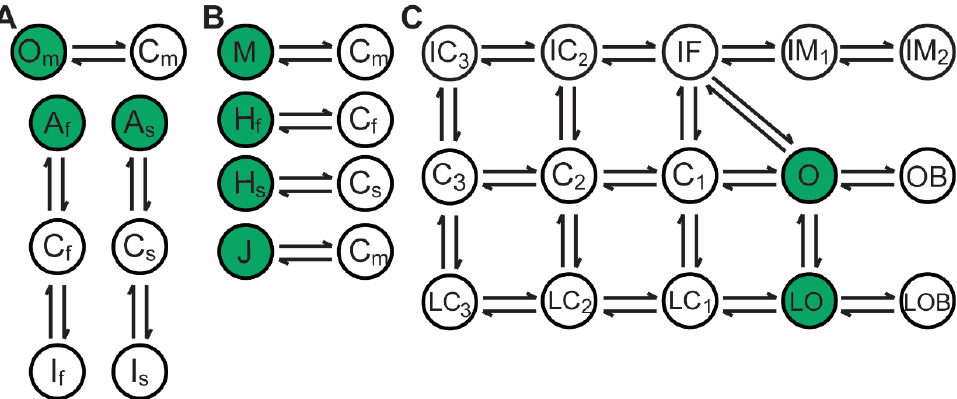
Figure 1. Examples of three different biophysical models of the volgate-gated Na + (Na v ) channel. Open/Active states are indicated in green, while closed/inactive states are white. ( A ) Our novel hybrid Na v model with 3 independent components, an activation component (subscript m ), and two inactivation components for fast and slow inactivation (subscripts f and s , respectively). The activation component consists of an open ( O m ) and closed ( C m ) state, while the inactivation components each consist of an active state ( A ), a closed state ( C ) and an inactivated state ( I ). ( B ) Example of a Hodgkin-Huxley type model consisting of 4 independent gating variables: activation ( M ), fast inactivation ( H f ), slow inactivation ( H s ) and recovery ( J ) [20,24]. ( C ) A Markov model where channel gating is represented as transitions between coupled states, including inactivation (I X ), closed (C X ), and open states (O). Additionally, there are further states to allow for late current (L X ), and for drug block ( X B) [22].